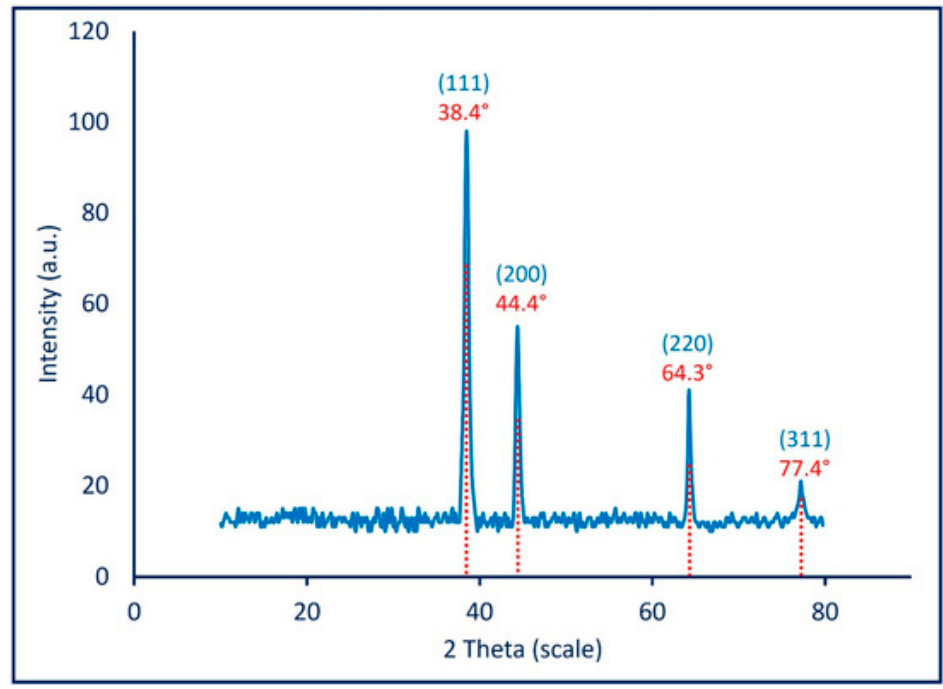
Figure 7. XRD diffraction for Ag NPs through mycosynthesis Reprinted from an open source article [121].